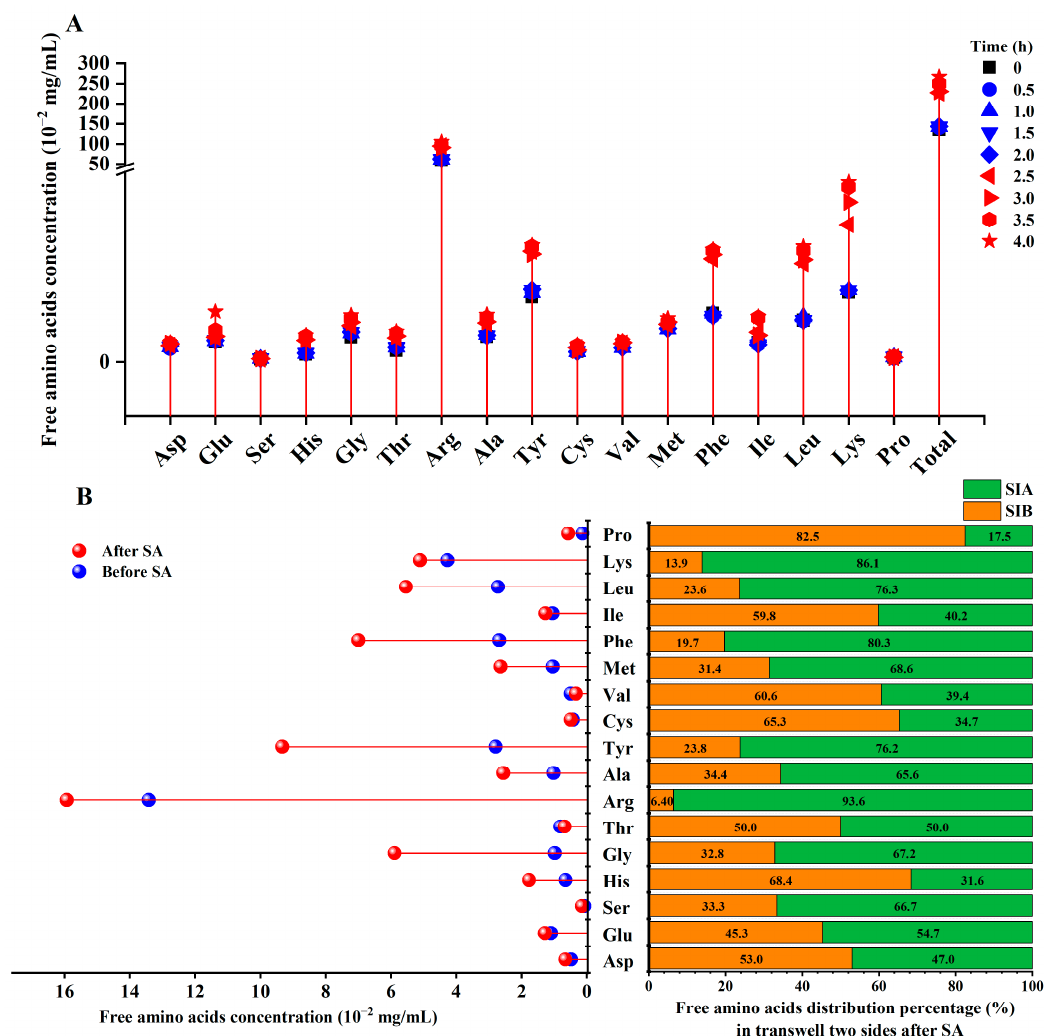
Figure 2. The alteration in free amino acids during simulated gastrointestinal digestion ( A ) and ab- sorption ( B ). Asp: aspartate; Thr: threonine; Ser: serine; Glu: glutamate; Gly: glycine; Ala: alanine;